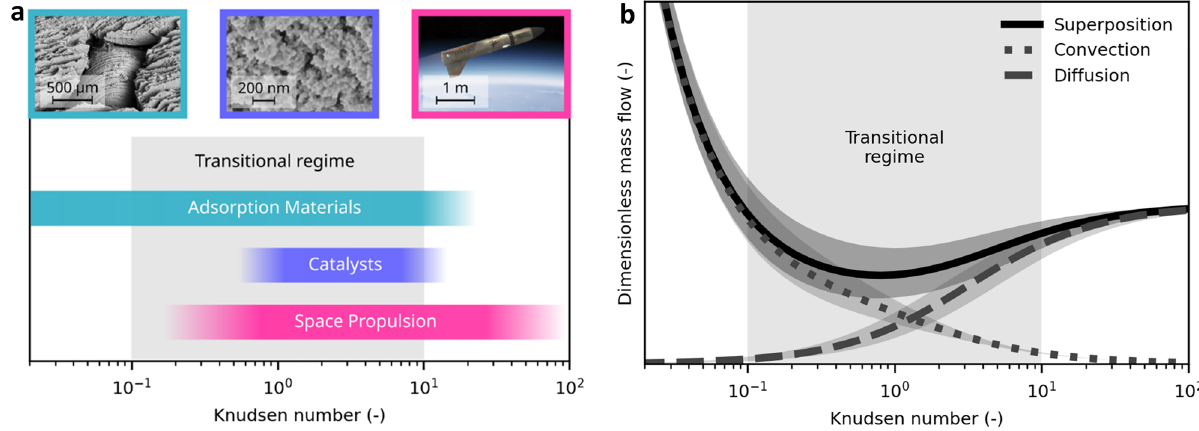
Figure 1. Rarefied gas flow in technical applications and its dependence on the molecular diameter. ( a ) Typical Knudsen regions of technical applications. Materials for gas adsorption (cyan) can have pore sizes ranging over multiple orders of magnitude. In combination with large changes in pressure or temperature in swing- adsorption applications, the result is a wide Knudsen range. In catalysis (blue), products and educts often face small structures at high temperatures and Knudsen numbers larger than unity at atmospheric pressure can be observed. In space applications such as propulsion modules (magenta), the Knudsen numbers tend to be very large due to the low pressure in orbit. See Supplementary Text 1 for details on the Knudsen ranges. Left image: SEM image of a hierarchical structured zeolite adsorbent. Center image: SEM image of a Sm 2 O 3 xerogel catalyst. Right image: Depiction of the ReFEx vehicle 21 . ( b ) Schematic illustration of the individual transport terms of the superimposed model and their variation with the Knudsen number. The convective part decreases with rising Knudsen number while the diffusive part becomes dominant at Knudsen numbers larger than unity, because of the increasing mean free path. The diffusive part converges to a constant value at high Knudsen numbers where the surrounding geometry is the limiting factor for diffusion. The sum of both components reproduces the typical and well- known Knudsen minimum at approximately Kn = 1. The influence of the molecular diameter on the predicted mass flow is illustrated by the shaded